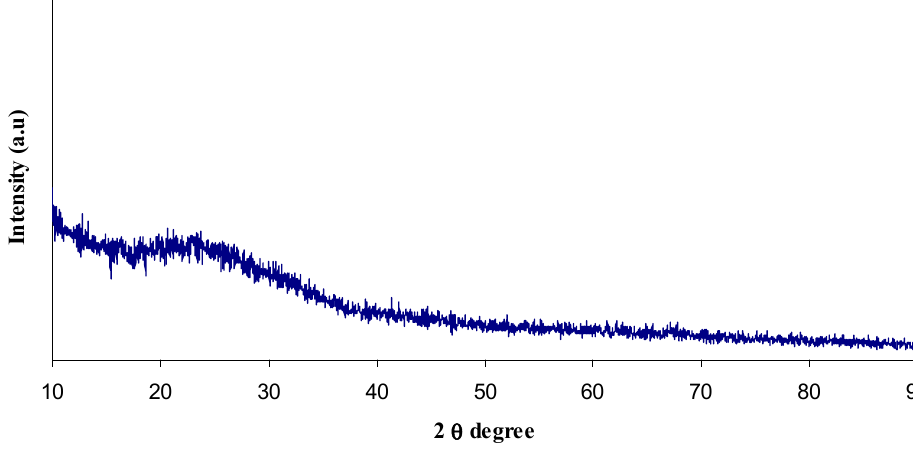
Figure 5. XRD pattern for synthesized copper complex as deposited.